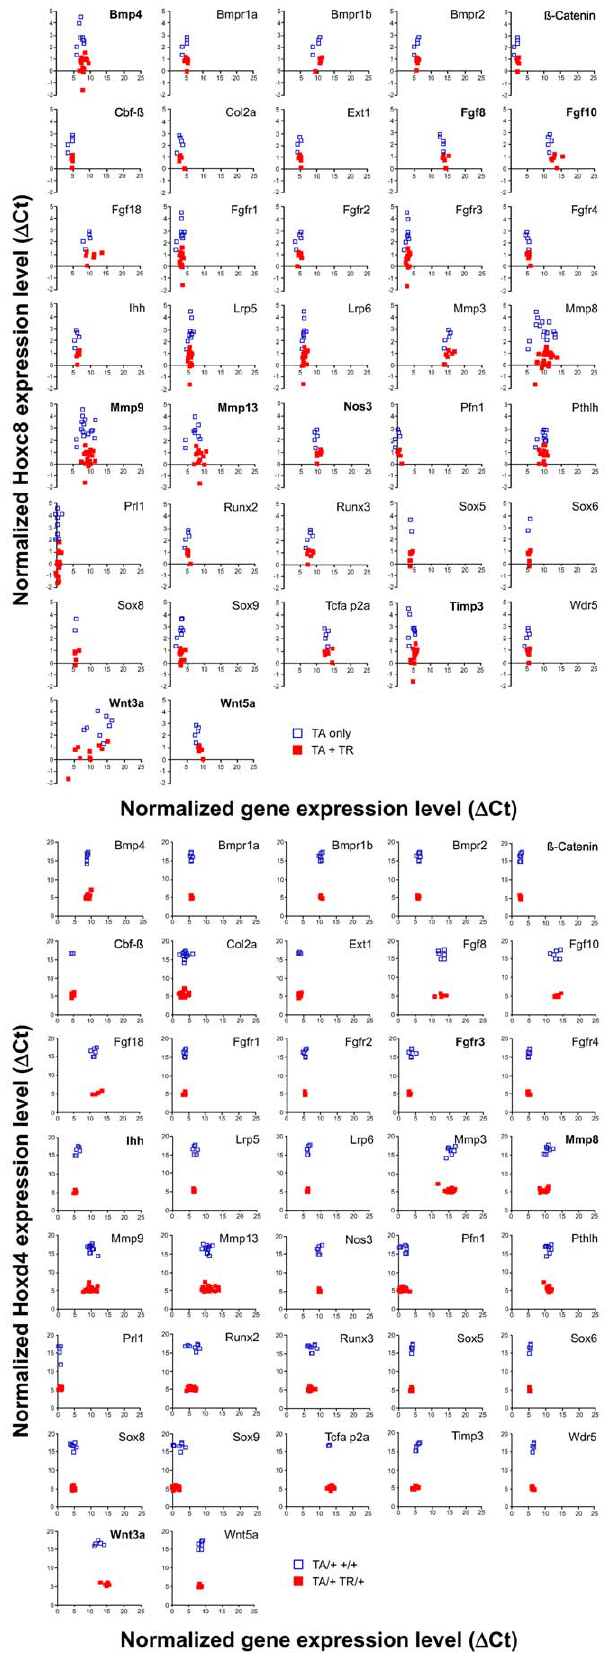
Figure 1. Gene expression in Hoxc8- and Hoxd4-transgenic chondrocytes. Quantitative real-time PCR was performed in triplicate on cDNA prepared from mRNA that was isolated from primary rib chondrocytes. Rib cages were dissected at 18.5 days of gestation from individual Hoxc8- ( A ) and Hoxd4- ( B ) transgenic mouse embryos. Gapdh cDNA levels in each sample were used to standardize measurements. The results are plotted as Gapdh-normalized D C T values for each gene relative to Gapdh-normalized Hoxc8 or Hoxd4 gene expression ( D C T ) in each sample. Low D C T values reflect higher relative expression levels, and high D C T values reflect low relative levels of gene expression. Each dot represents an individual animal (filled symbol = TR-containing samples, open symbol = controls). Bold panel labeling indicates statistical significant differences in expression levels between transgenic and control